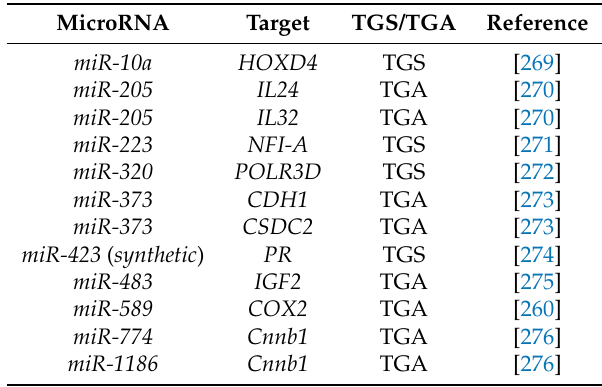
Table 3. MicroRNAs acting as transcriptional